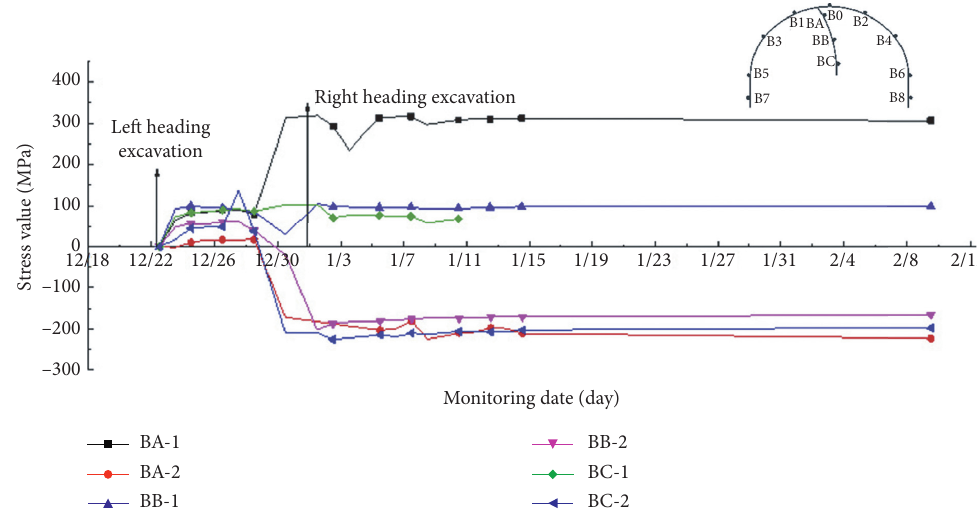
Figure 12: Stress temporal curves at the middle wall of steel rib at section YK2+